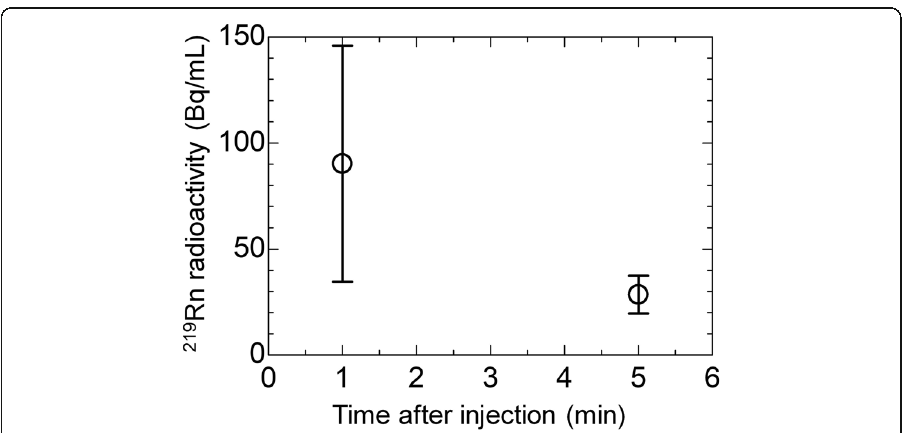
Fig. 5 Mean value of 219 Rn per unit volume of exhaled breath at 1 min and 5 min after the start of 223